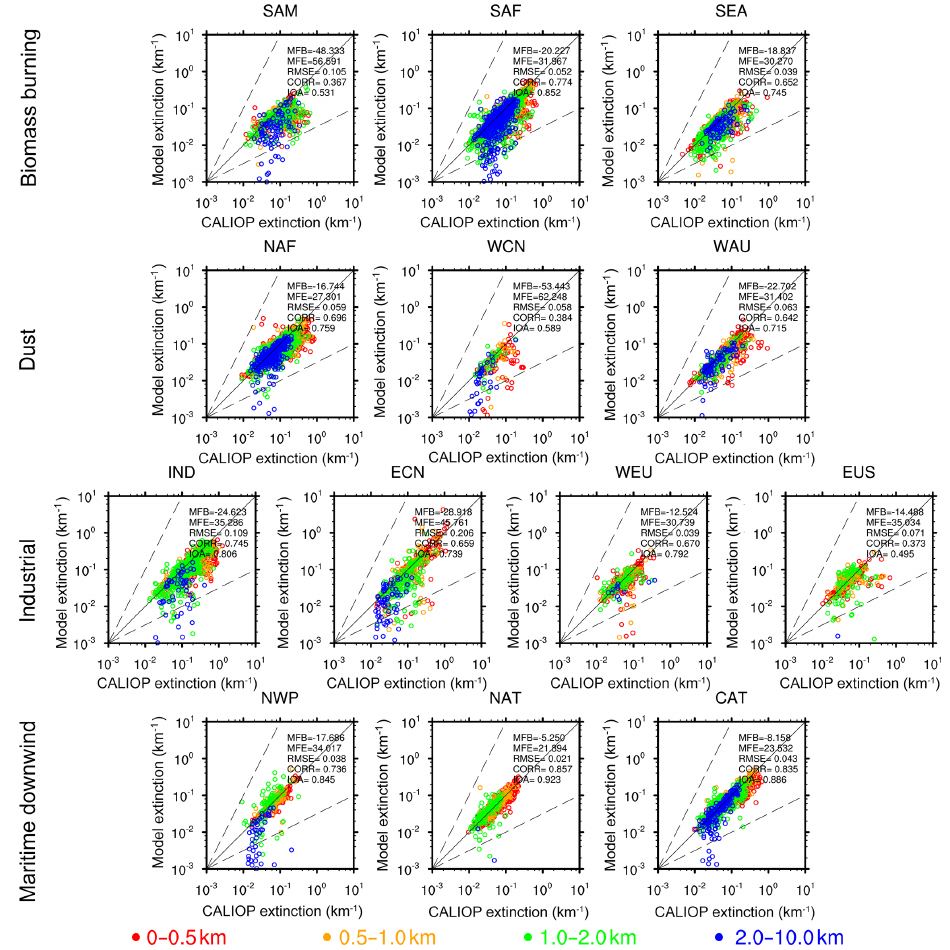
Figure 6. Same as Fig. 4 but for the 4D-LETKF-24H-CALIPSO